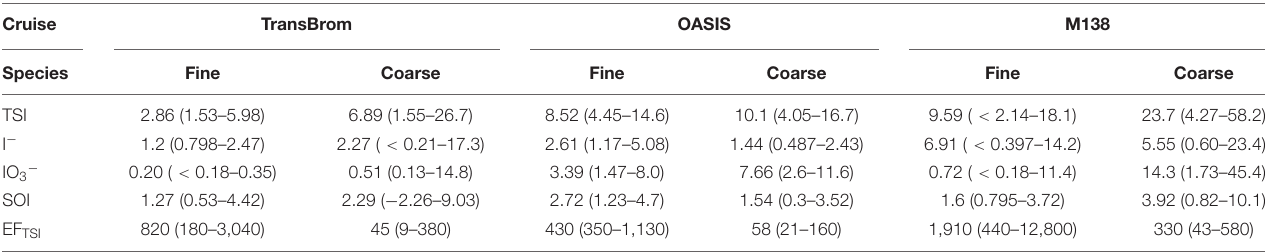
TABLE 5 | Median and range of soluble iodine species concentrations (pmol m − 3 ) and enrichment factor (EF) of TSI in fine and coarse mode aerosols the TransBrom, OASIS, and M138